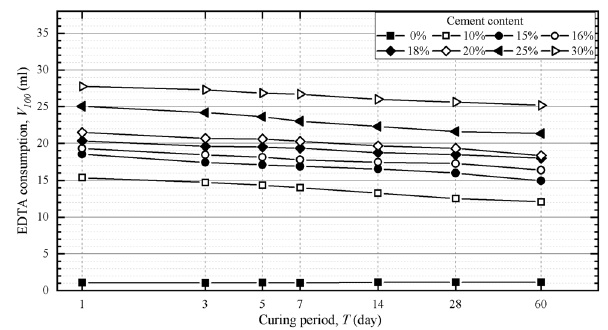
Figure 5. Variation of EDTA consumptions of different curing periods.